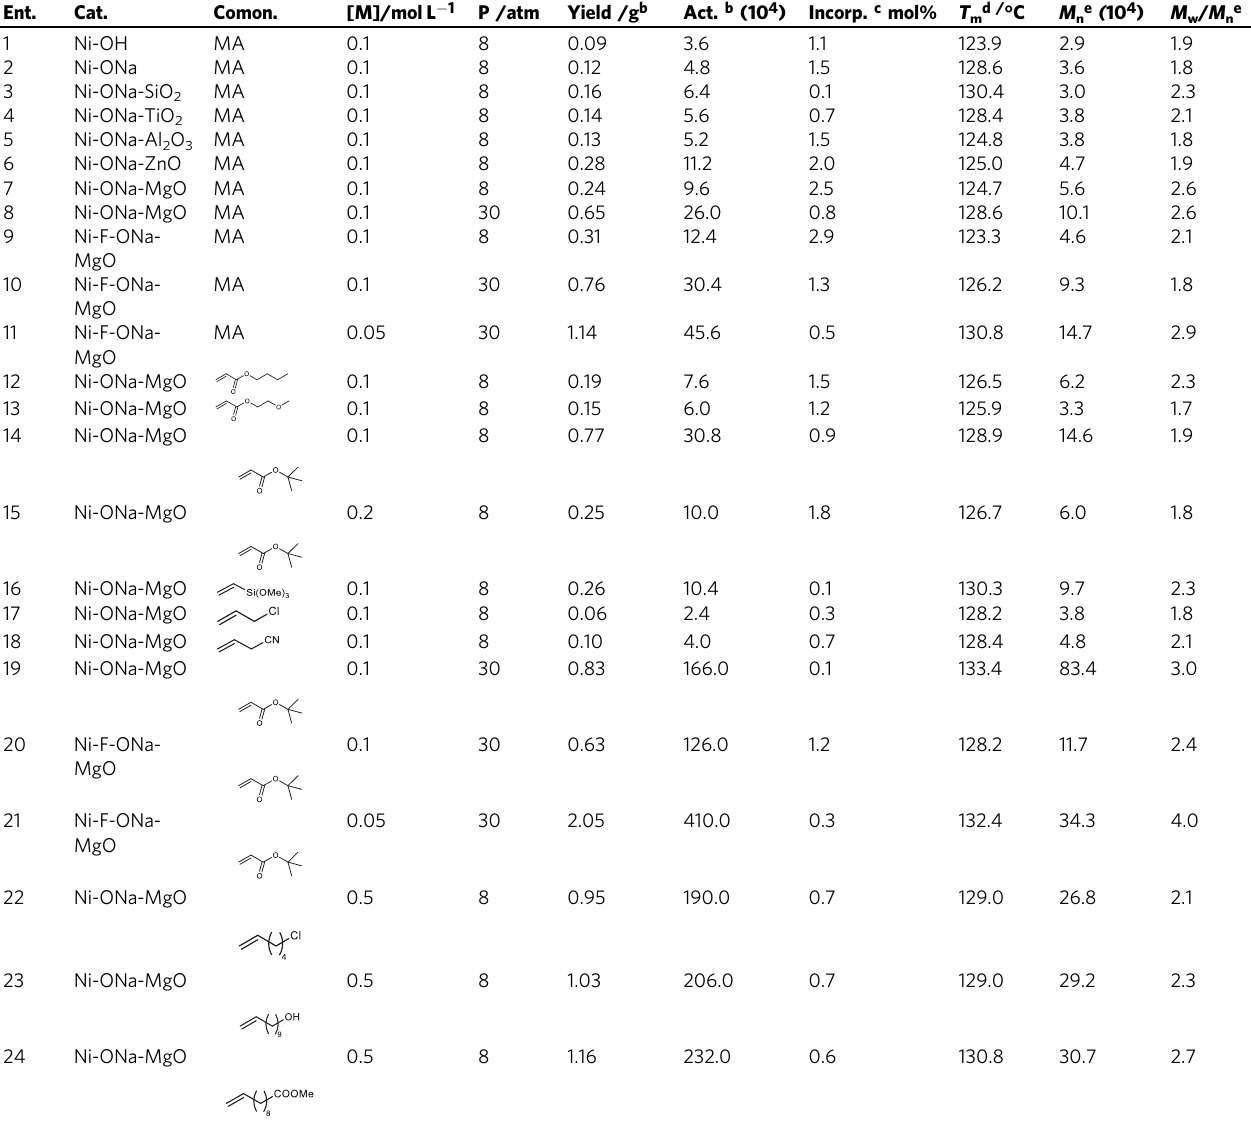
Table 2 Ethylene copolymerization with Ni catalysts a . Ent.